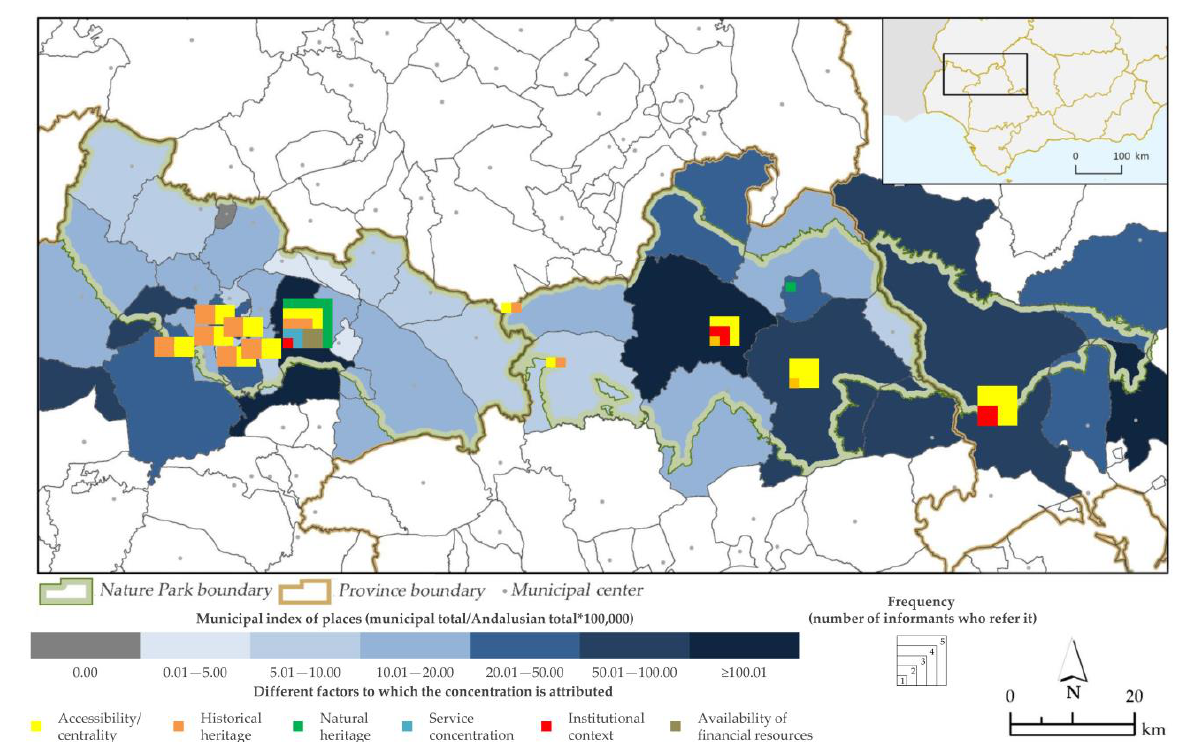
Figure 23. The concentration of tourist activity according to the stakeholders. Source: Interviews, 2021; authors ’ elaboration.